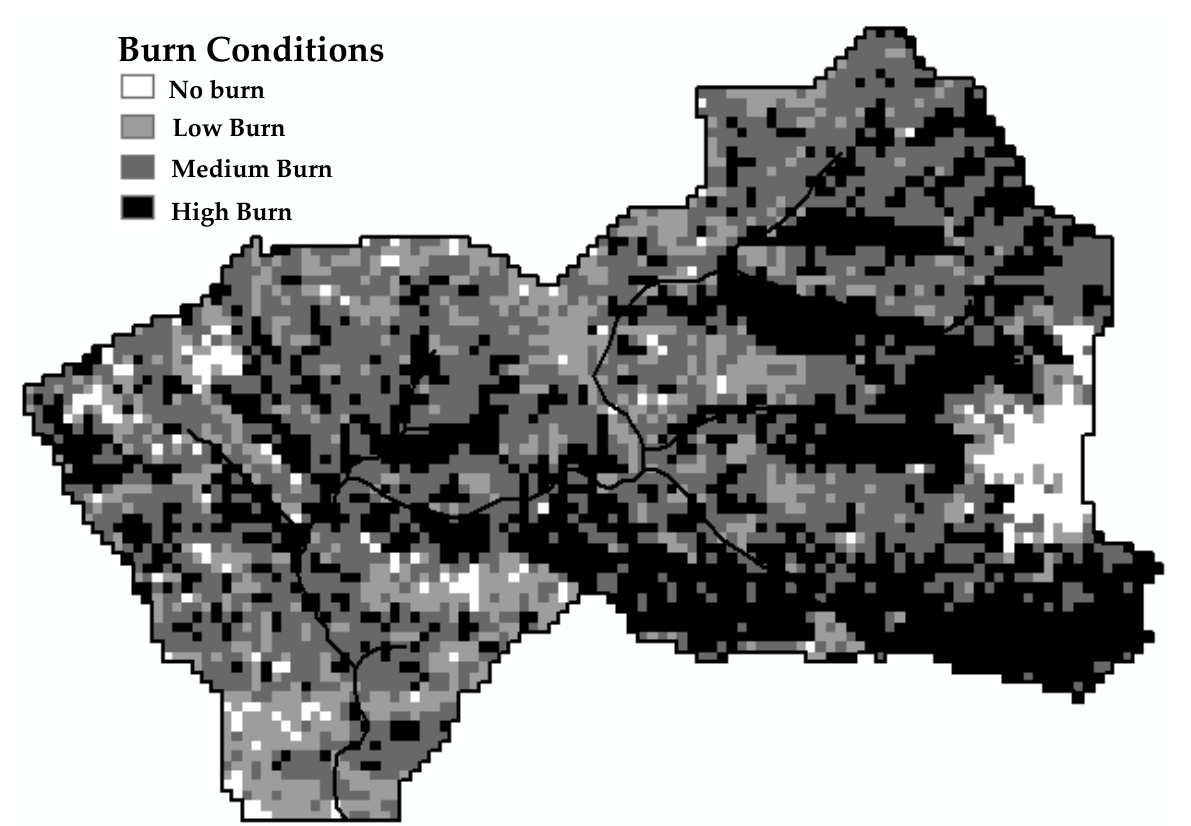
Figure 2. Upper Arroyo Seco burned severity map after the ‘Station Fire’ of August 2009.